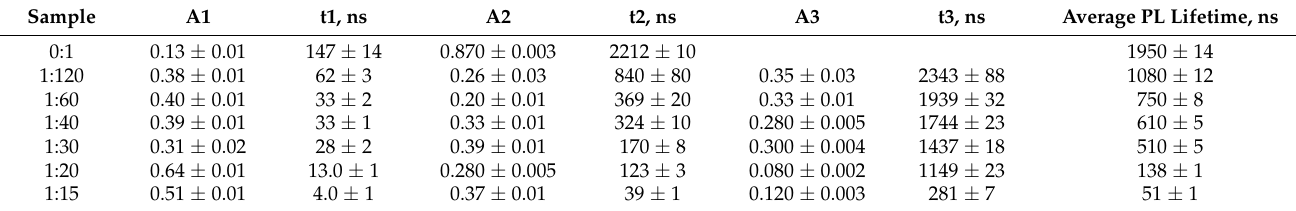
Figure 1. ( a ) PL decay curves of QD-rGO systems with various rGO/QD ratios; ( b ) average PL lifetimes for the QD-rGO systems plotted vs. rGO/QD ratio together with the curve calculated assuming that PL quenching is caused by Auger recombination and energy transfer. Table 1. PL decay curve fitting parameters for QD-rGO systems with various rGO/QD